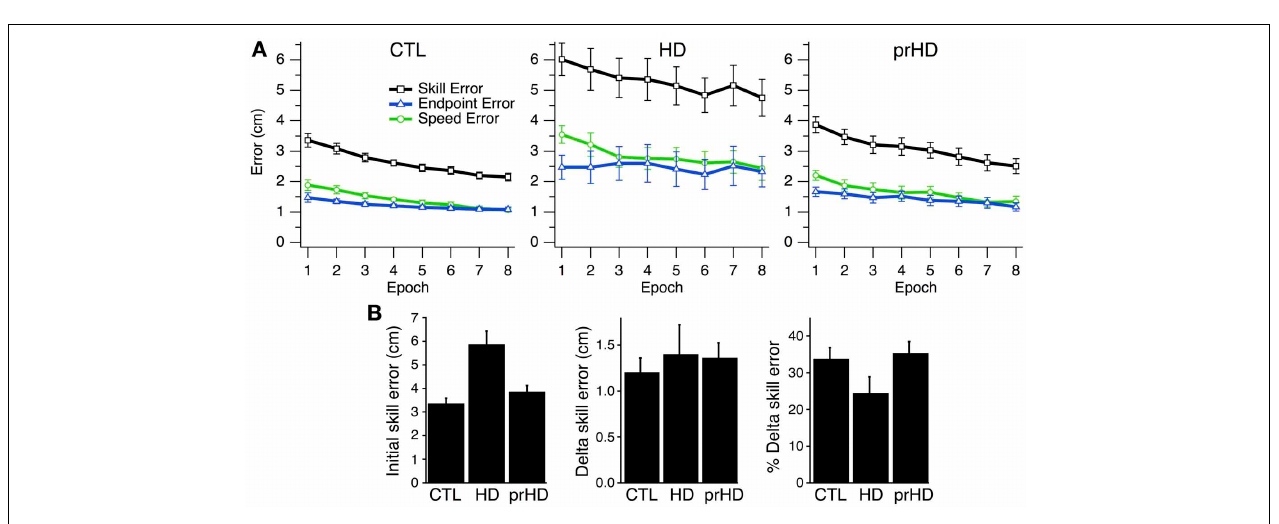
FIGURE 3 | Time course and group comparisons of skill learning. (A) Group averages (mean ± SE) of skill error (squares, black trace), endpoint error (triangles, blue traces), and speed error (circles, green trace) vs. epoch